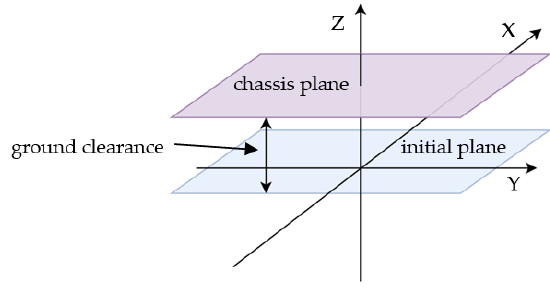
Figure 8. The parallel shift of the plane.